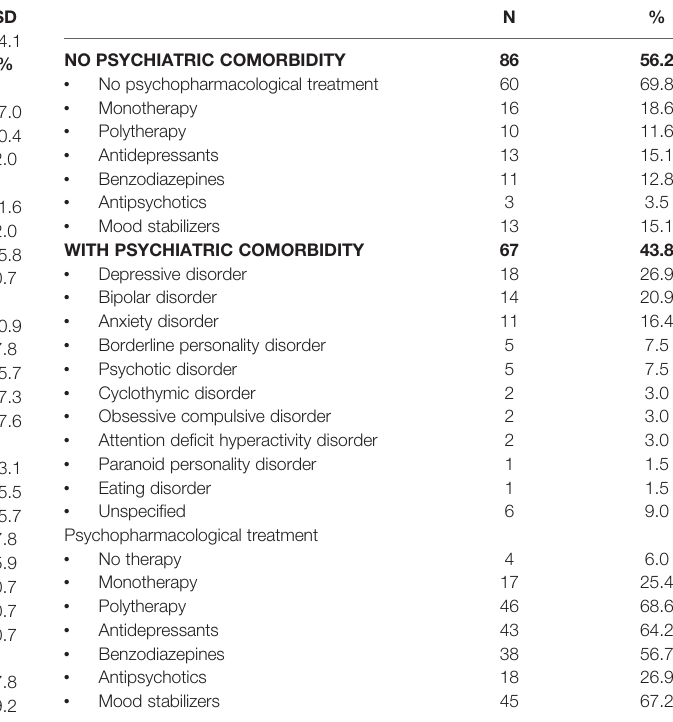
TABLE 2 | Psychiatric comorbidity in the full